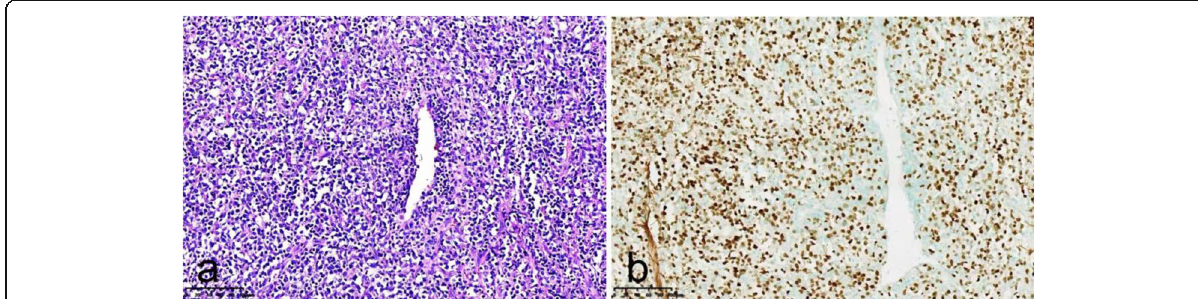
Fig. 1 Photomicrographs of nasal biopsy. a: Histologic photomicrograph of nasal biopsy (hematoxylin-erosin; × 20) showing fragmented tumor tissue. b: Immunohistochemical photomicrograph of nasal biopsy (EBER; × 20)